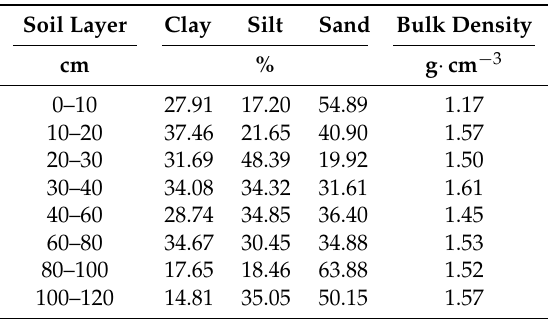
Table 1. Soil physical and hydraulic properties for the study